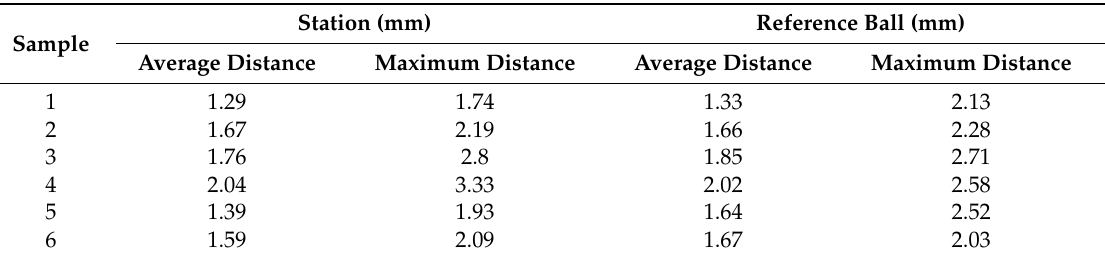
Table 3. Sample registration error.